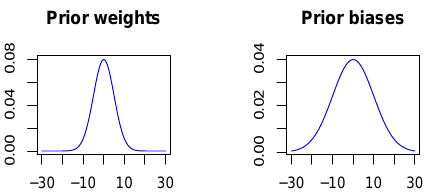
Figure 4. Visualization of the a priori distribution. Bias terms may take on larger values since they act on